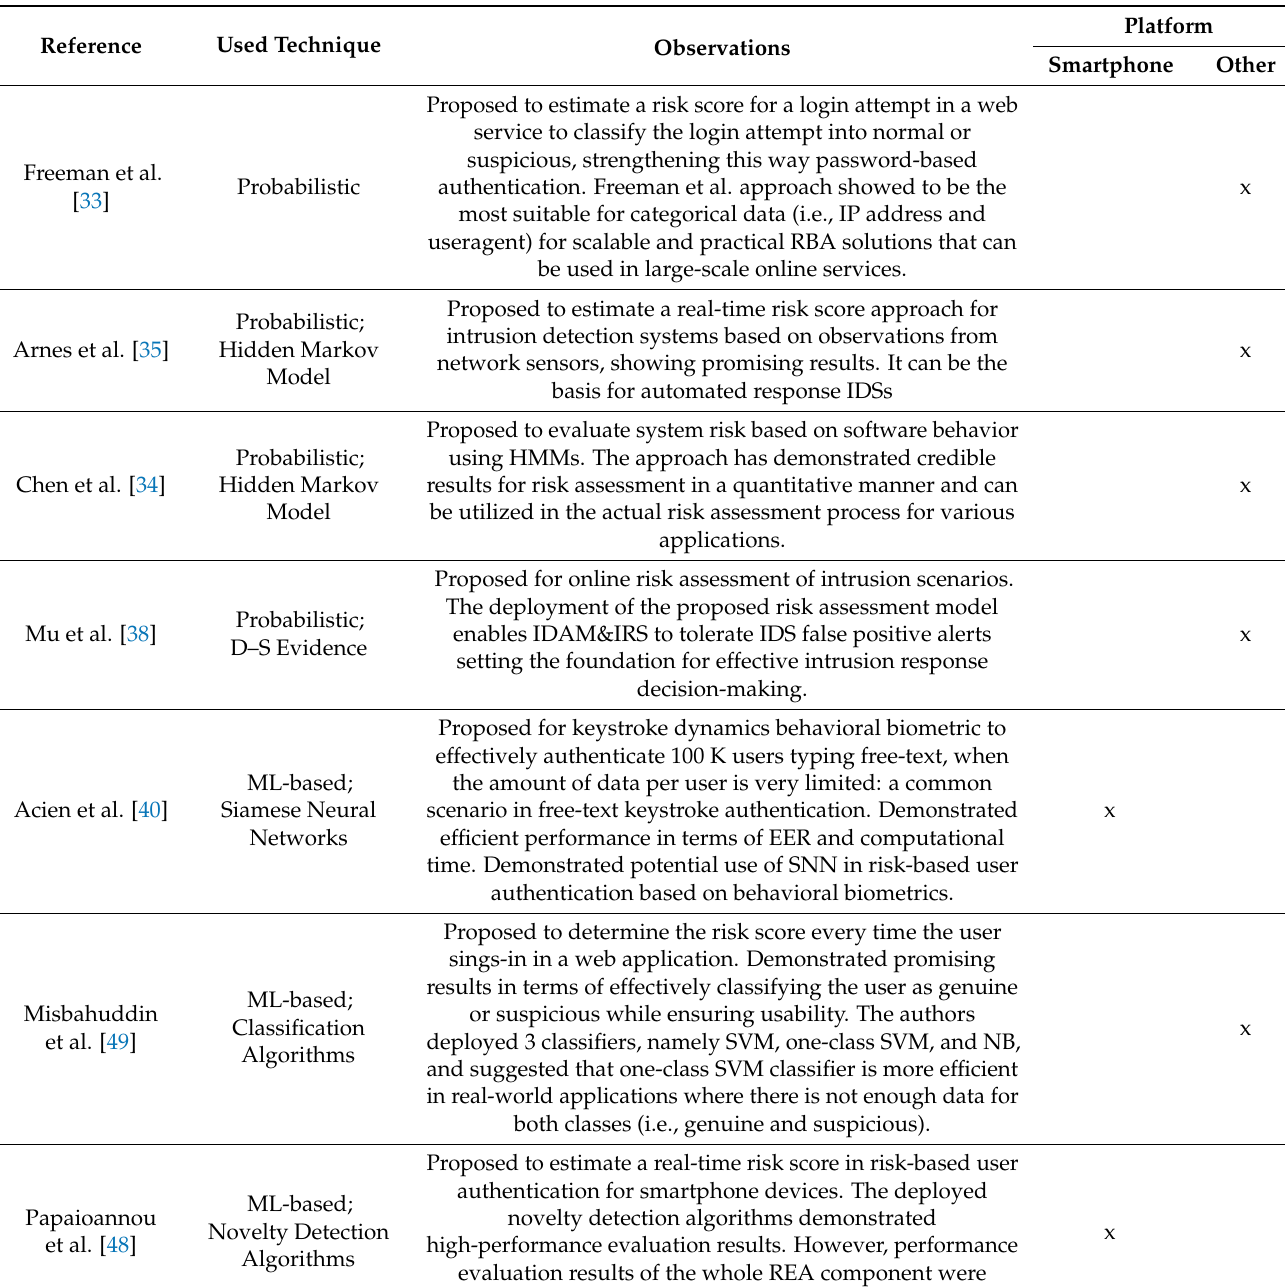
Table 7. Taxonomy of Quantitative Risk Estimation Approaches